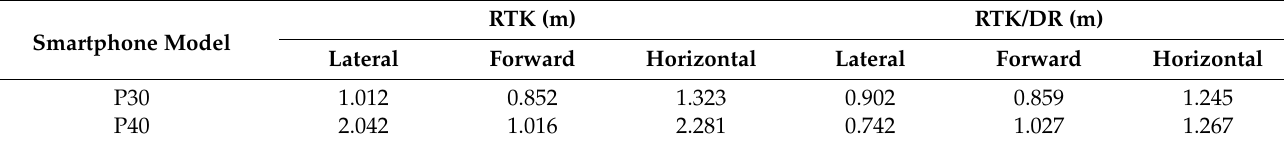
Table 4. Statistics of positioning error RMS of Smartphones Huawei P30 and